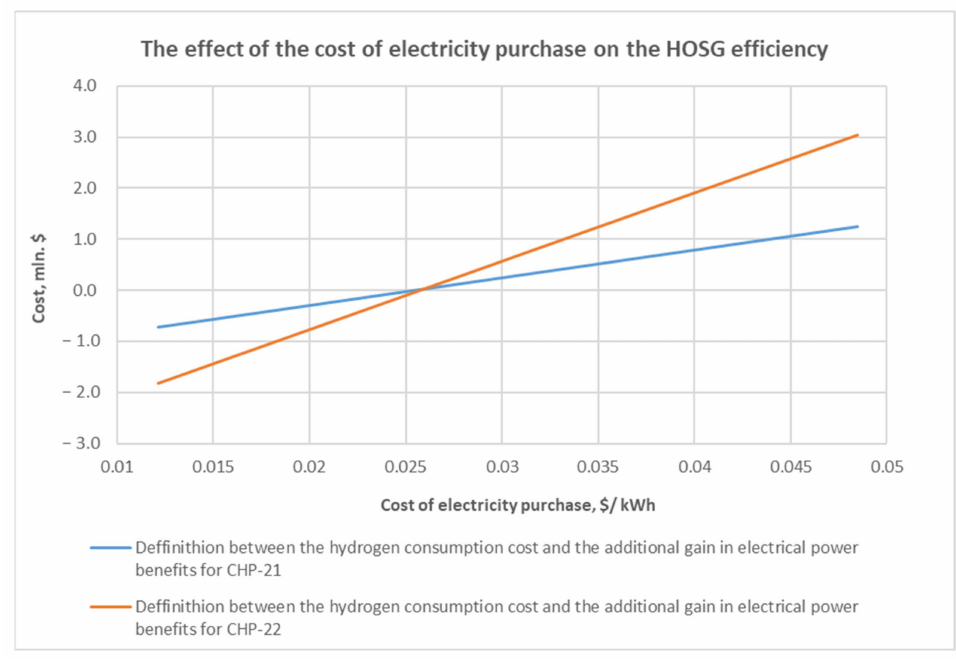
Figure 13. The effect of the cost of electricity on the HOSG efficiency in the case of superheating of the hot steam at the outlet of the boiler unit to the maximum currently possible temperature of 565 ◦